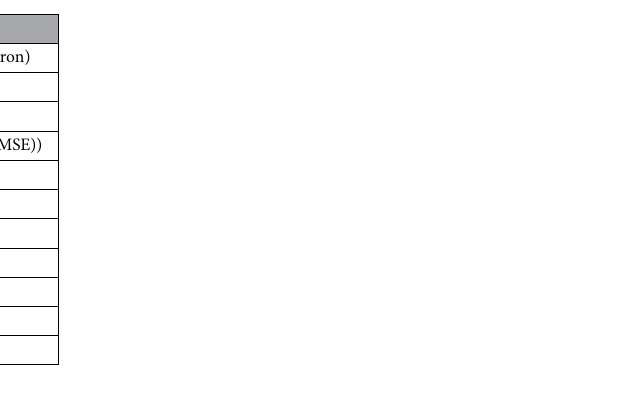
Table 2. The ANN